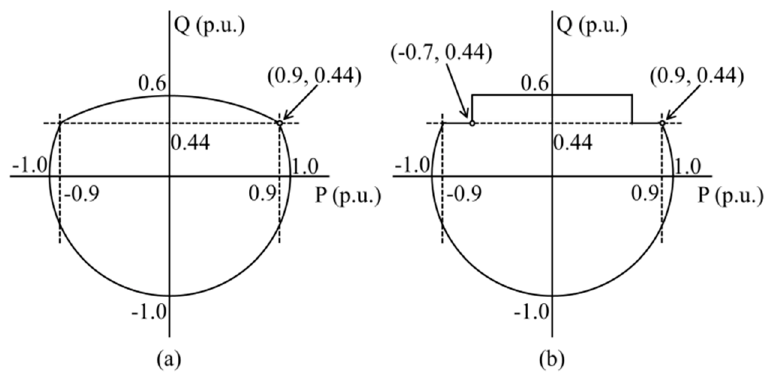
Figure 3. VSC terminal model from the use of the MTDC and the Controllable Reactive Power Source (CRPS).